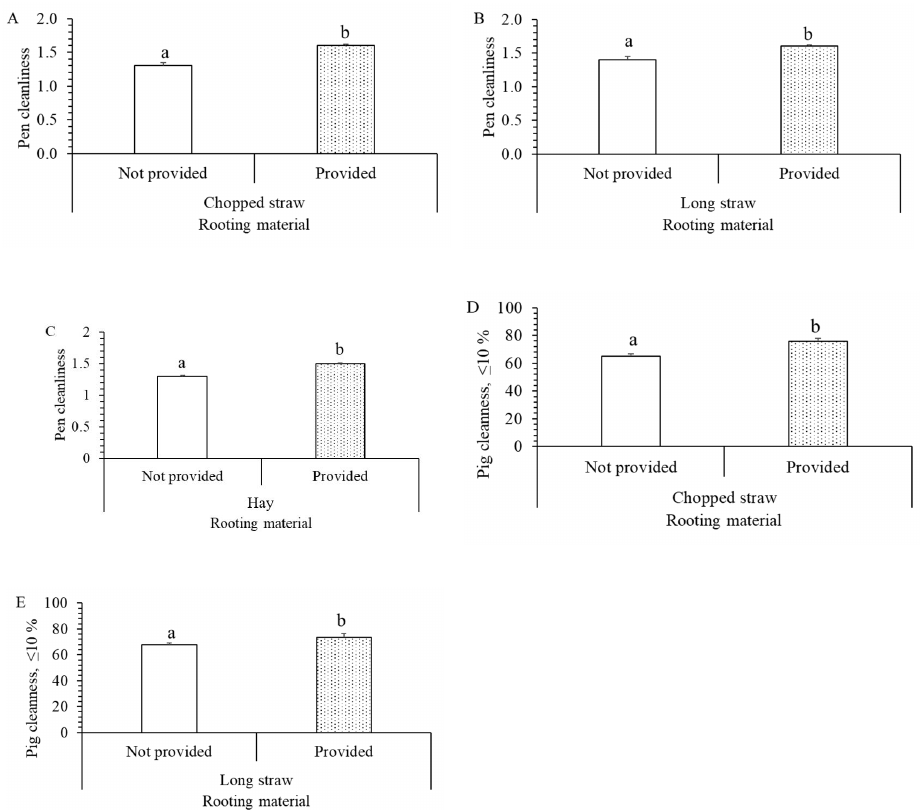
Table 6. Effect of litter amount on pen, pig cleanliness and ammonia concentration.